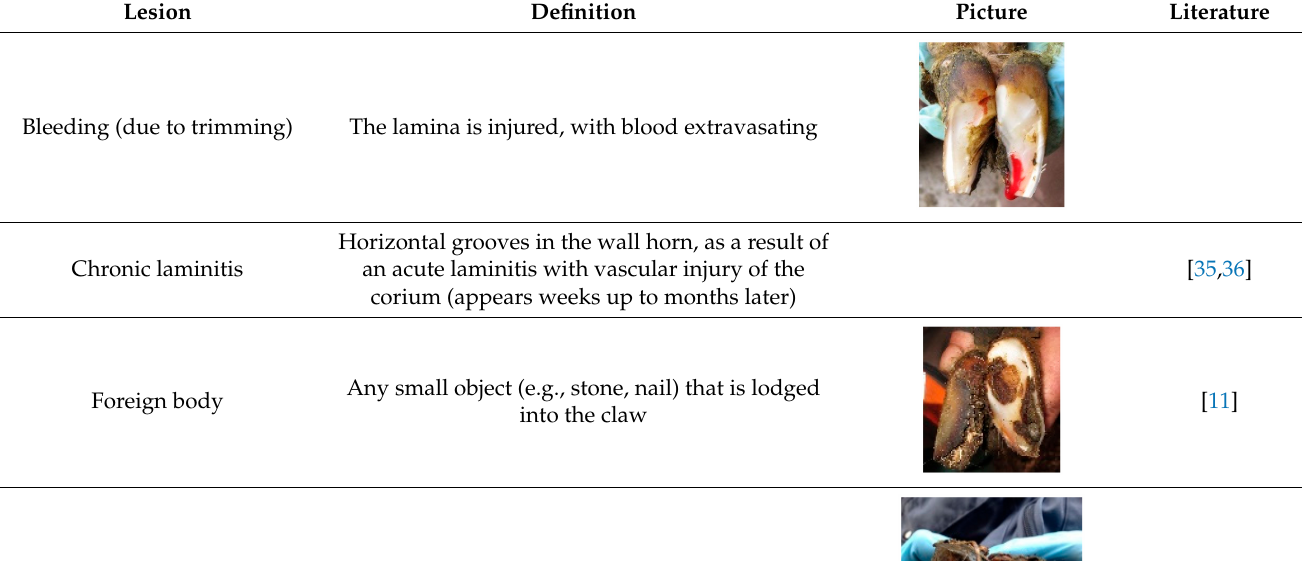
Table 2. List of the lesions documented on the claw card, their definition supplemented with pictures and references. Lesion Definition